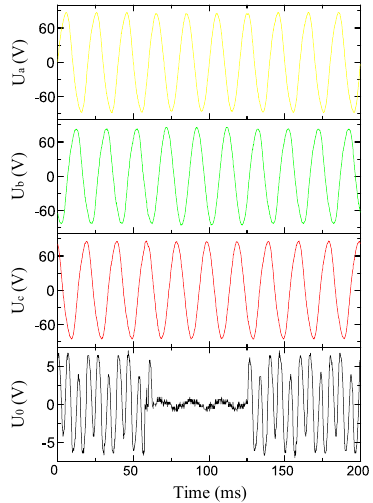
Figure 15. Voltage waveform when the insulation is normal.